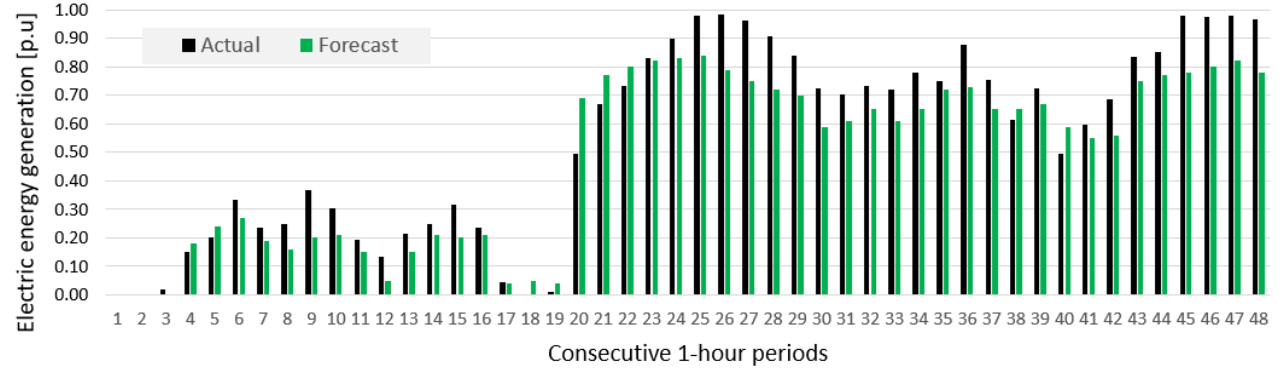
Figure 22. Two forecasts of electric energy generation for Wind Farm B made by INT_OUT_EXT